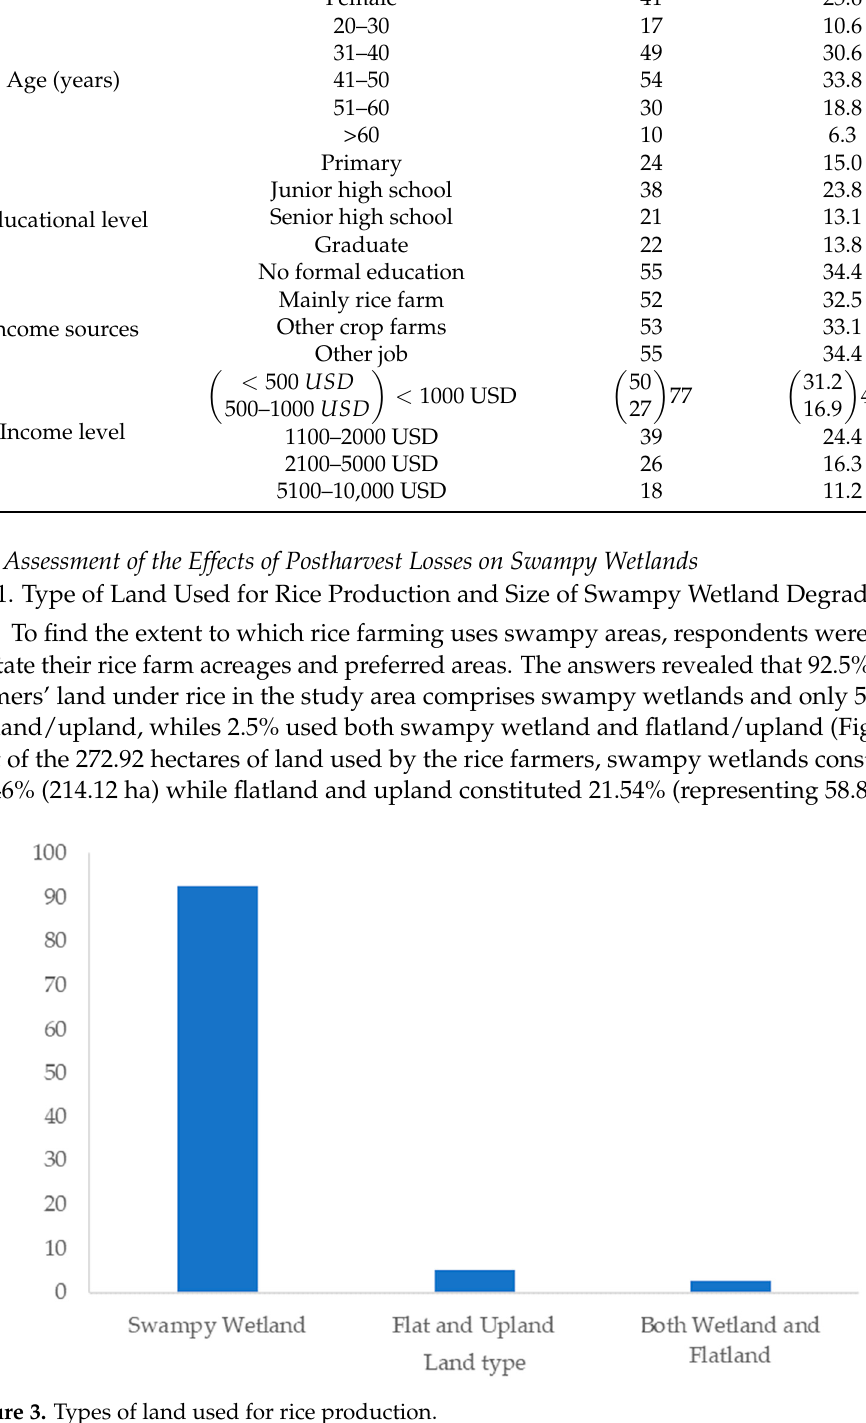
Figure 3. Types of land used for rice